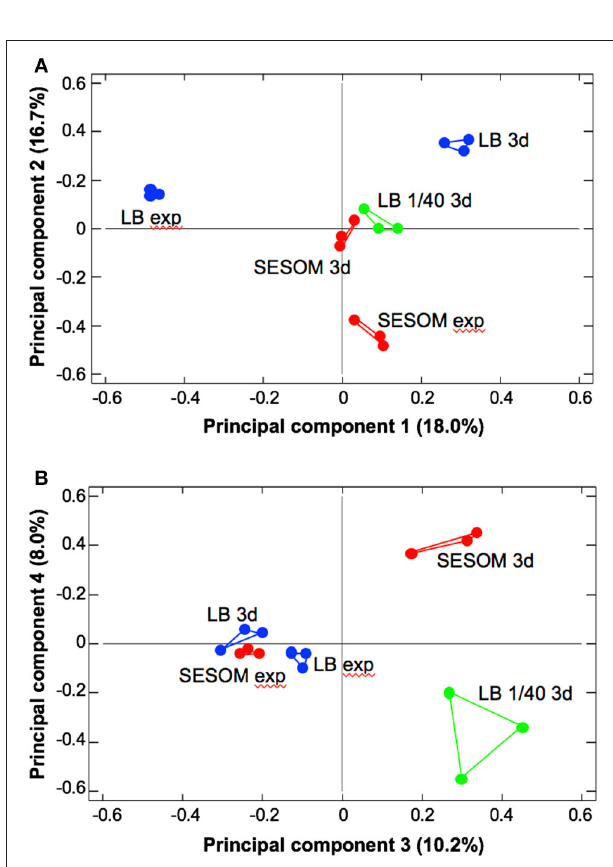
FIGURE 3 | Principle component analysis of exponential (exp) and stationary phase (3d) proteomes of E. coli O157:H7 933D cultured in LB, 1/40strength LB and SESOM at 30 ◦ C. Four components with Eigen values > 1 were revealed, shown as principle components 1 and 2 (A) and 3 and 4 (B) .